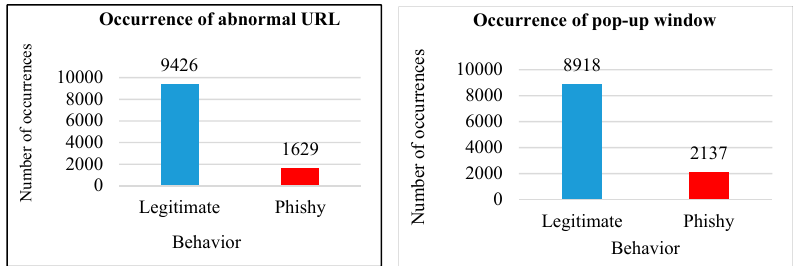
Figure 4. An overview of all features in the phishing dataset (the number of occurrences of each feature with three different behaviors).